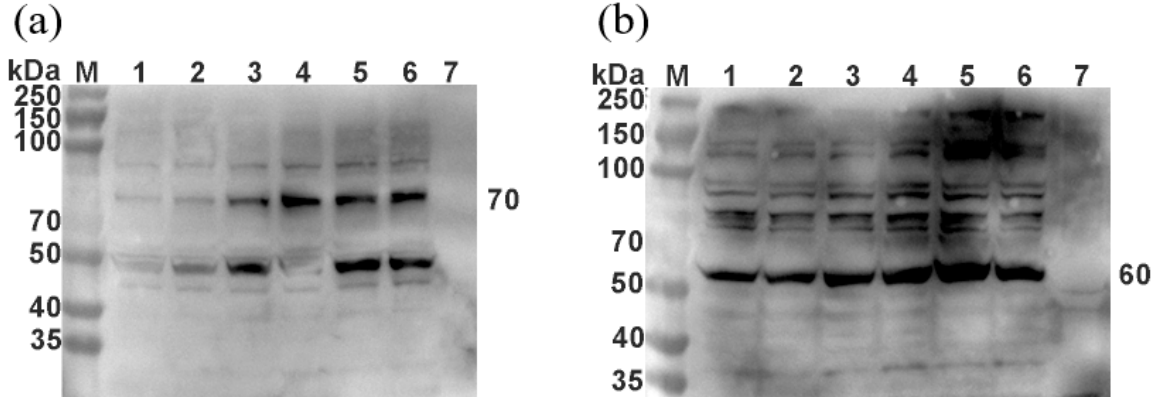
Figure 4. Identification of the recombinant viruses rSRV9-H and rSRV9-F via Western blot. The P3, P6, P9, P12, P15, and P18 generations of recombinant RABV rSRV9-H and rSRV9-F were collected and subjected to Western blot analysis using rabbit PPRV H and PPRV F polyclonal antibodies. ( a )